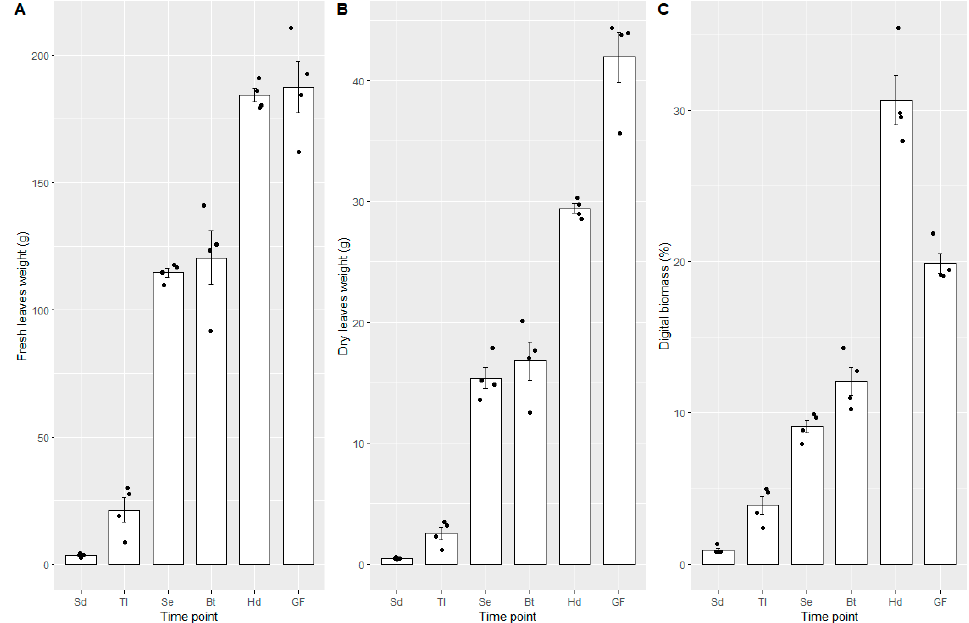
Figure 5. Fresh leaves ( A ), dry leaves ( B ), and digital biomass ( C ) obtained from different growth stages, namely, seedling (Sd), tillering (TI), stem elongation (Se), booting (Bt), heading (Hd), and grain filling (GF). Error bars are standard error.